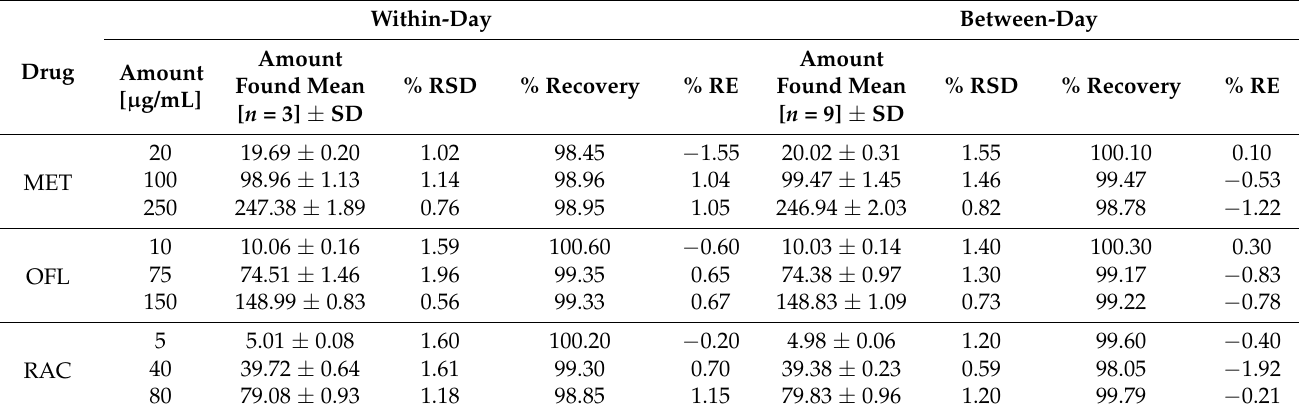
Table 2. Precision and accuracy results from the developed HPLC